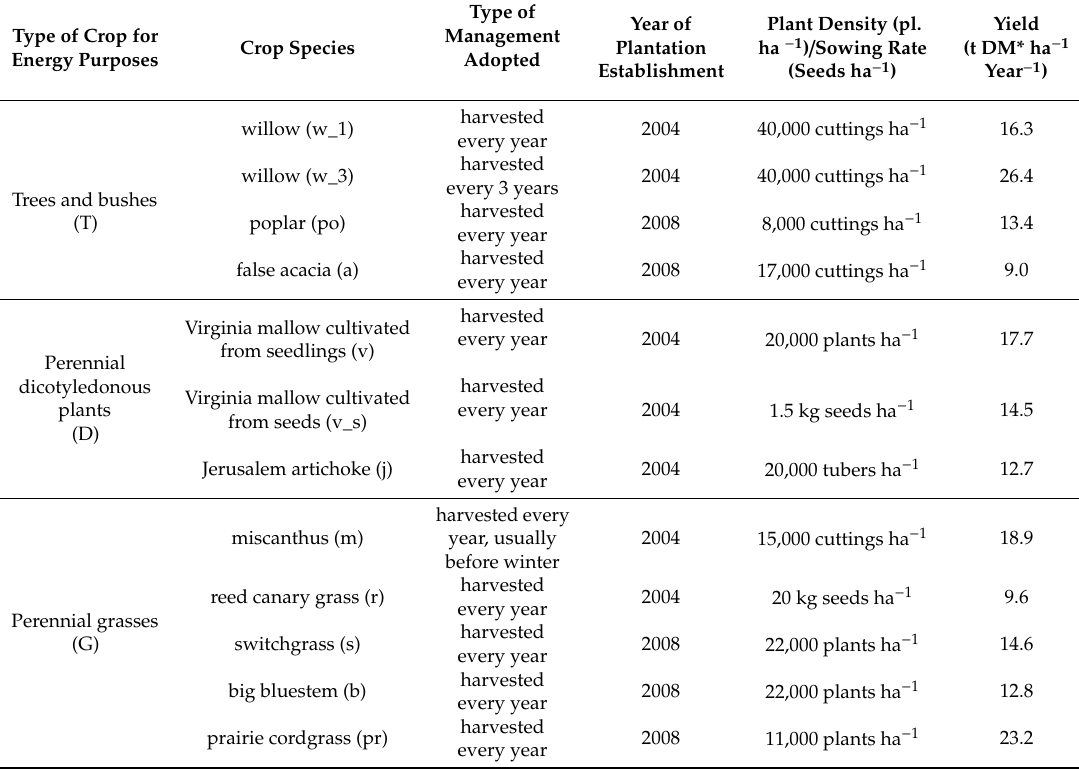
Table 1. Selected elements of the agricultural practices of crops cultivated for energy